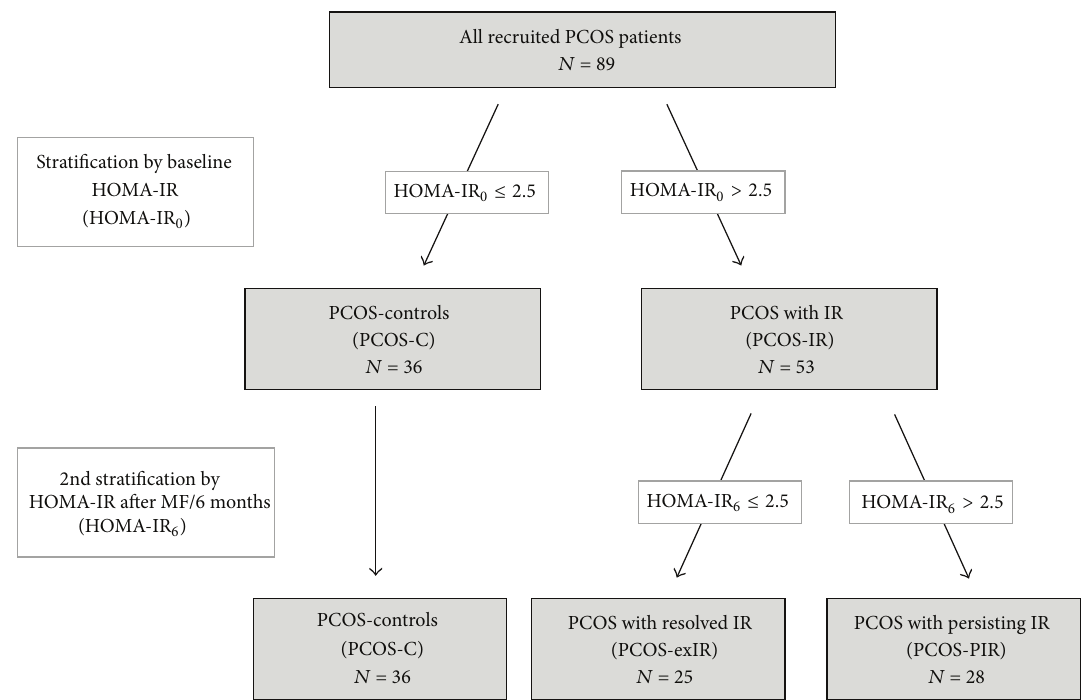
Figure 1: Stratification of PCOS patients according to HOMA-IR.